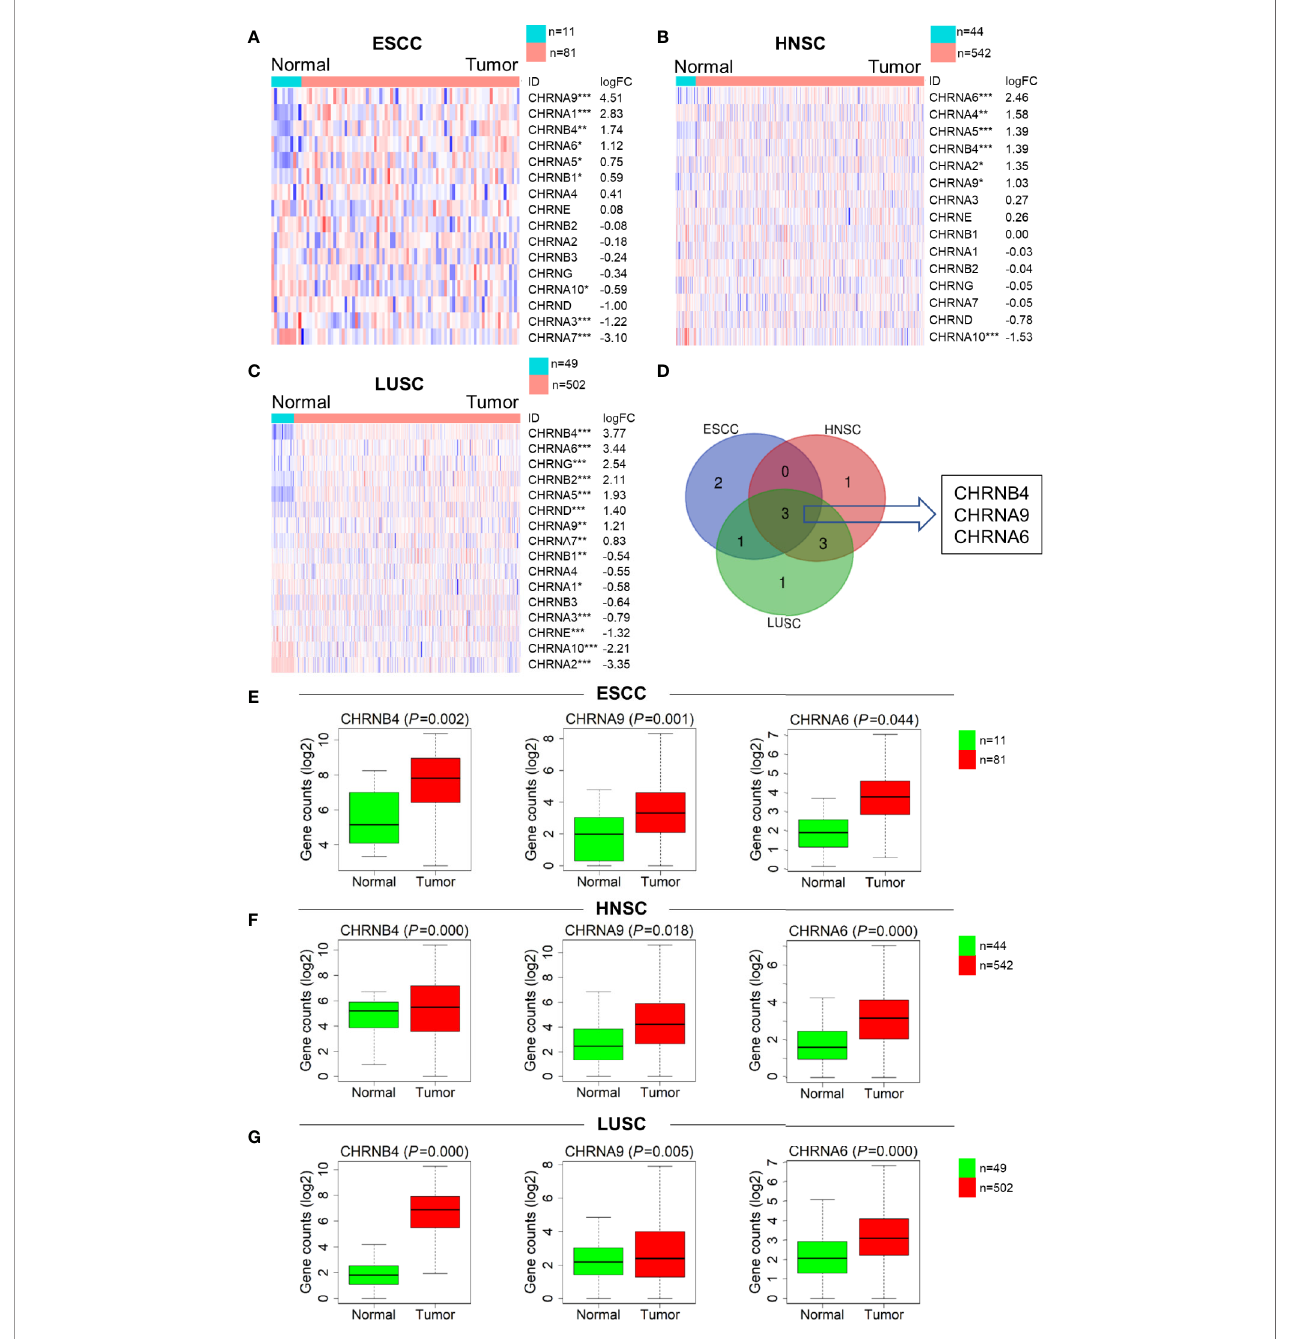
FIGURE 1 | Expression difference of the CHRNs between tumor (ESCC, LUSC, and HNSC) and normal samples. (A – C) Heatmaps of the complete CHRN family in 3 cancers in descending order of logFC. The red and blue colors represent high and low expression, respectively. *** P < 0.001; ** P < 0.01; * P < 0.05. (D) The Venn diagram of the DEGs in ESCC, LUSC, and HNSC . (E – G) The box diagrams showed expression levels of 3 genes between normal and tumor in